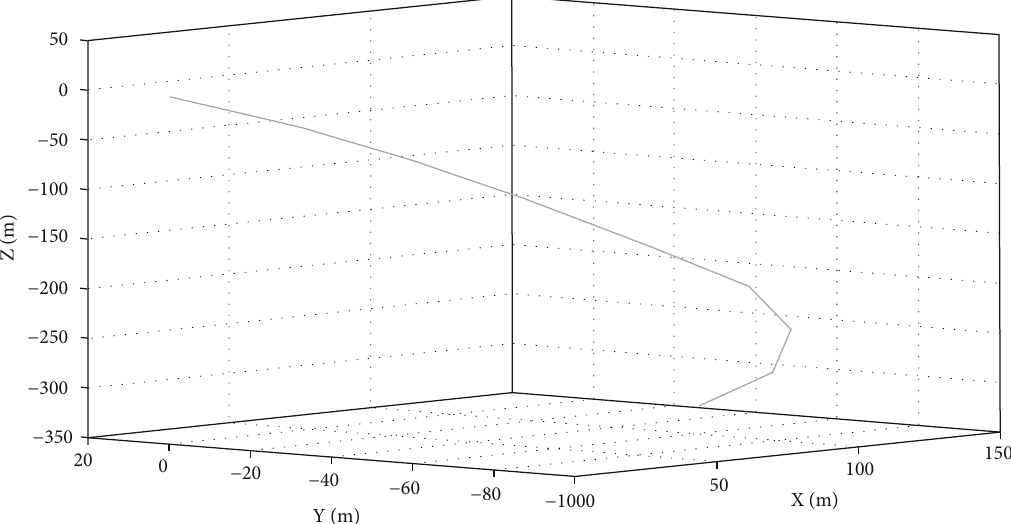
Figure 12: The trajectory of the spacecraft to the goal.